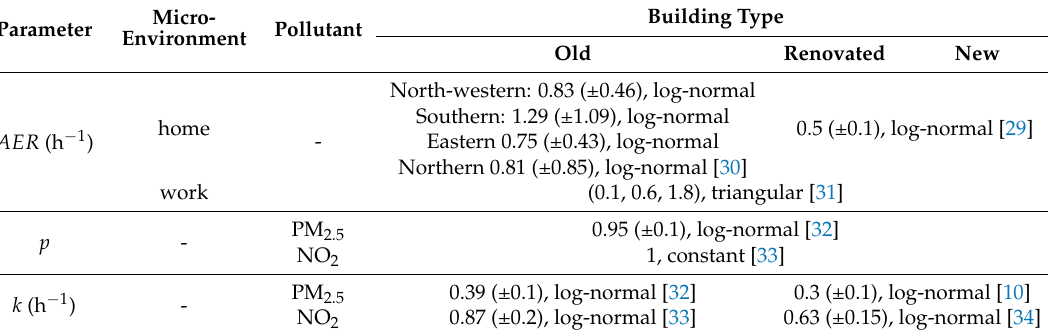
Table 1. Values of air exchange rate, penetration factor and decay rate.